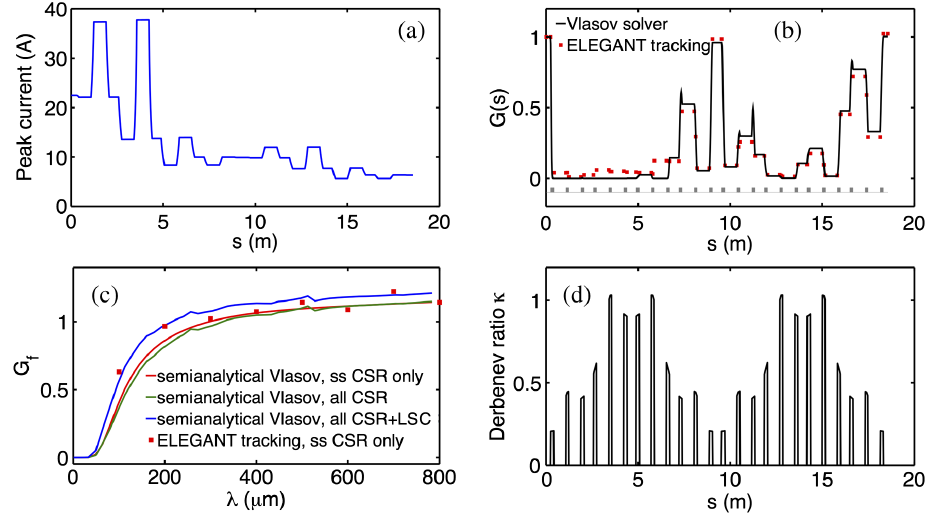
FIG. 6. (a) Bunch decompression along the arc; (b) microbunching gain function G ð s Þ for λ ¼ 300 μ m; (c) gain spectrum; (d) Derbenev ratio as a function of s . Red dots represent ELEGANT tracking with steady-state (ss) CSR